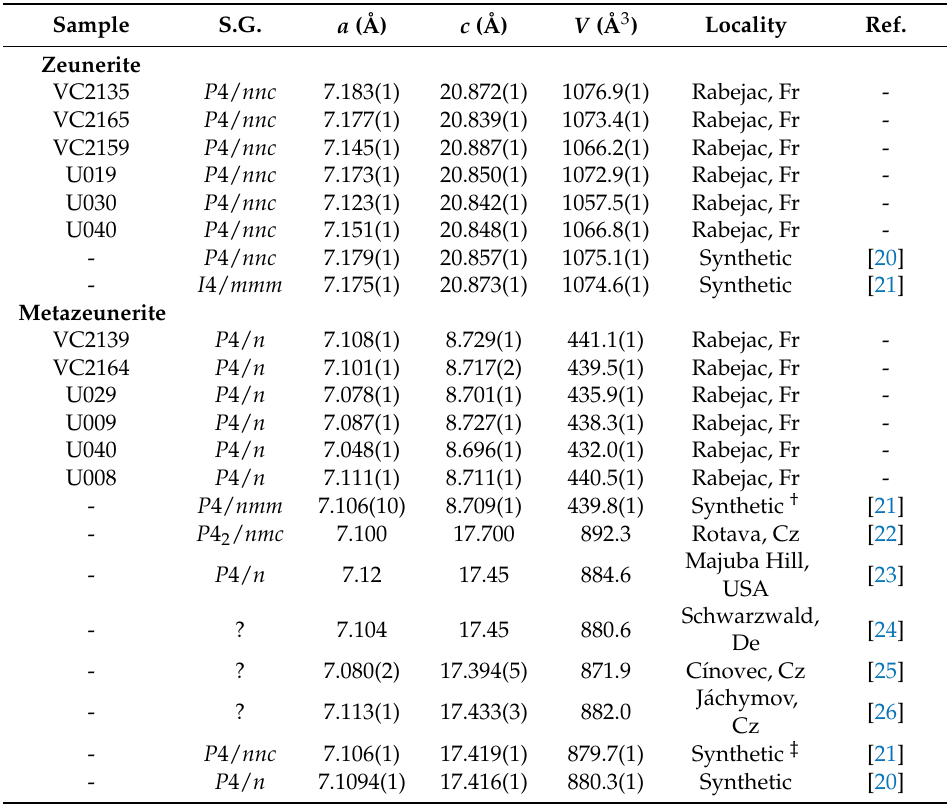
Table 3. Unit-cell parameters refined from Single-Crystal X-ray Diffraction (SXRD) for zeunerite and